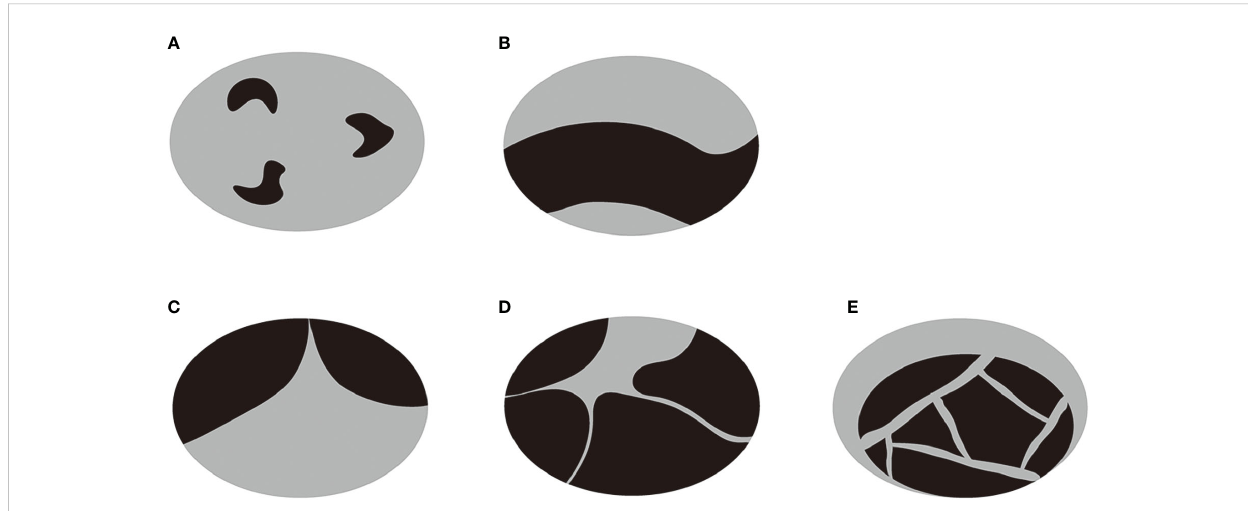
FIGURE 1 A diagram of the classi fi cation of PTCNs. (A) One or more small cysts were scattered among continuous solid component. (B) Discontinuous solid components were adhered to the wall separated by cystic component. (C) There was one septum in the largest cyst. (D) There were several septa in the largest cyst with a radial pattern. (E) There were several septa in the largest cyst with a random pattern. The type A and B were non-segregated nodules, and type C, D and E were segregated